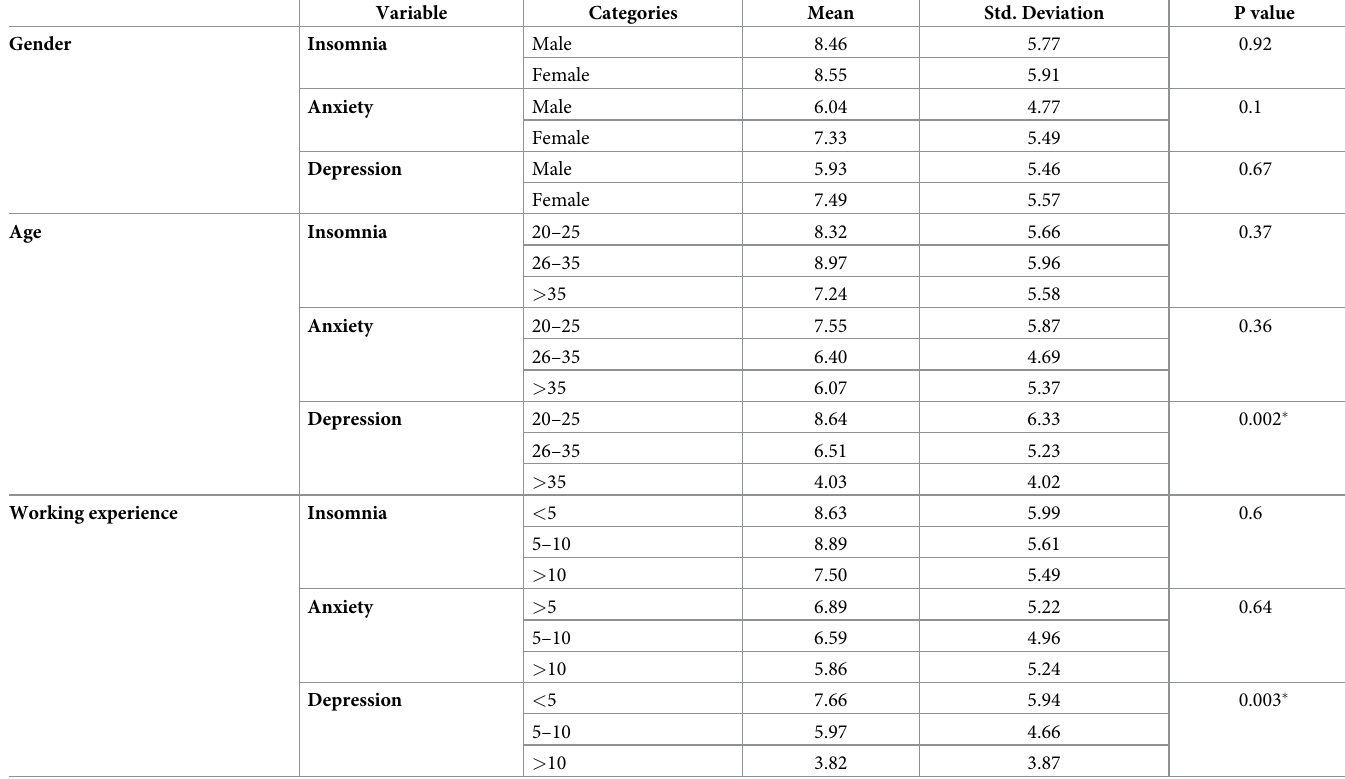
Table 5. Statistical analysis for mental health disorders based on gender, age, and working